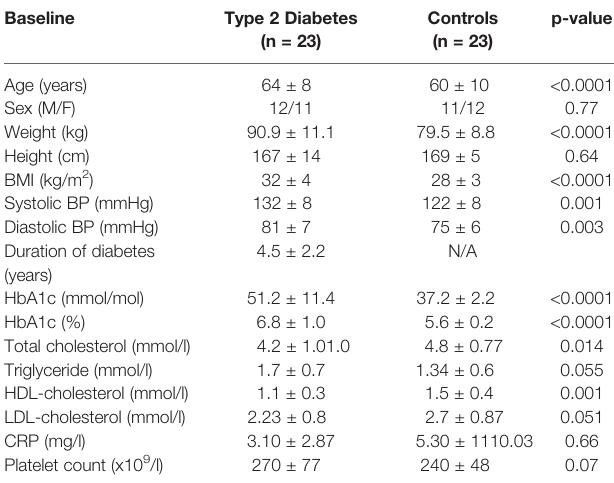
TABLE 1 | Demographic and clinical characteristics of the study